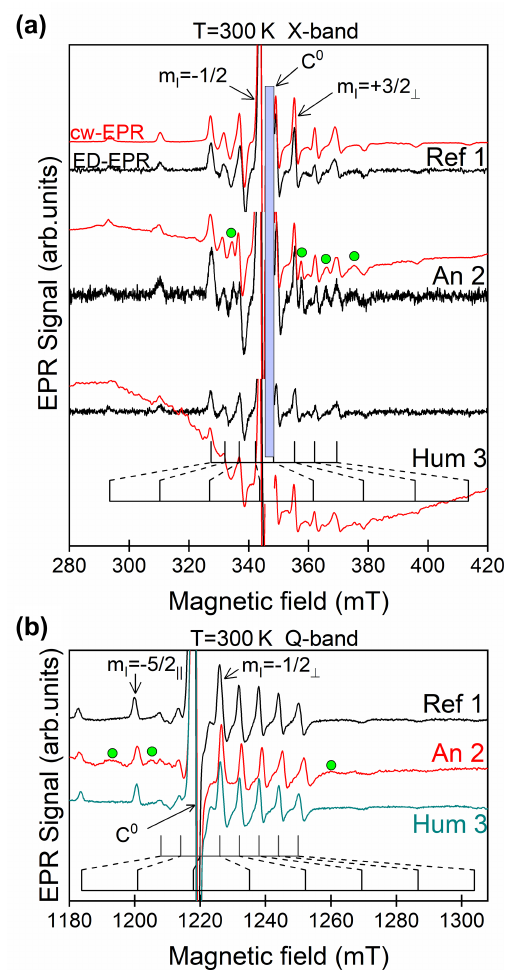
Figure 2. EPR spectra at room temperature of the black matter from samples Ref 1, An 2 and Hum 3. (a) cw-EPR spectra (in red) and pseudo-modulated ED EPR spectra (in black) at X band; the vertical blue area represents the position of the sharp C 0 signal that has been suppressed for the sake of clarity. (b) cw-EPR spectra at Q band. Some EPR lines of VO-nP complexes in An 2 are represented by green circles. The magnetic field settings for ENDOR (at Q band) and HYSCORE (at X band) experiments correspond to 51 V hf lines marked by arrows.